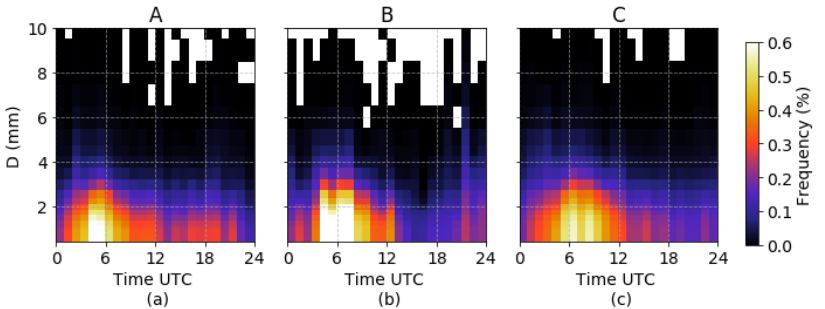
Figure 6. 2D histograms of D (mm) as a function of time (UTC) for Regions A ( a ), B ( b ), and C ( c ). LT is